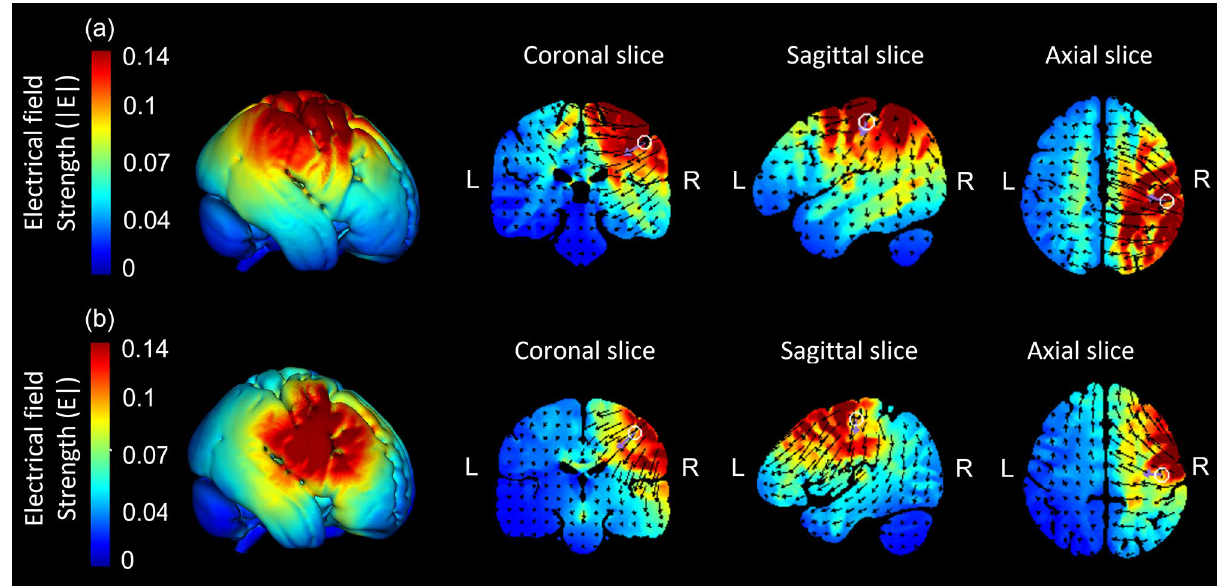
Figure 2. Current flow modeling during 1 mA High-definition transcranial direct current stimulation (HD-tDCS) using the HD-Target software (Soterix Medical, New York, NY). Current-flow models of ( a ) the right primary somatosensory cortex (S1) and ( b ) the right primary motor cortex (M1) are shown on 2D and 3D reconstructions of the cortical surface. Skin, skull, and cerebrospinal fluid (CSF) masks are suppressed to reveal the underlying gray matter mask. A head model derived from the MNI 152 dataset was